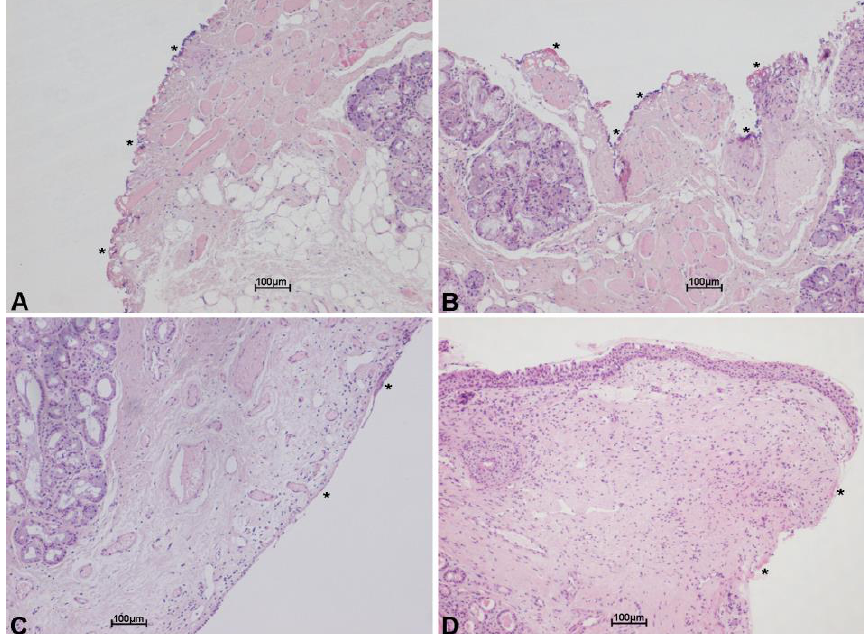
Figure 4. Histological images with hematoxylin and eosin stain, showing minimal thermal effects on the margin of the specimen excised with scanning micromanipulator and ultrapulsed technology. Thermal damage (*) on the connective tissue, along incision line. Scale bars ×10 ( A – D ). Table 2. Type of operation, histologic results and treatment